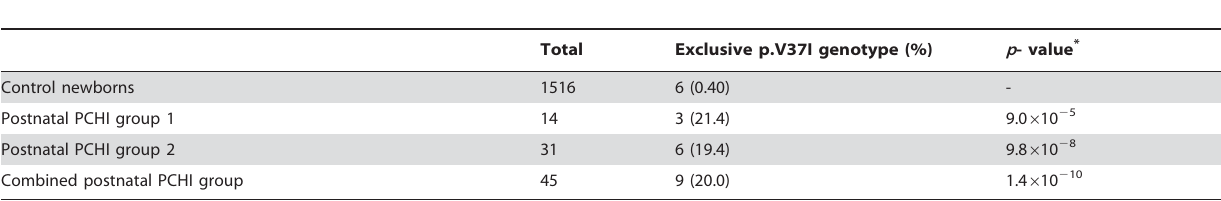
Table 2. Prevalence of the p.V37I exclusive genotype in control newborns and children with postnatal PCHI.